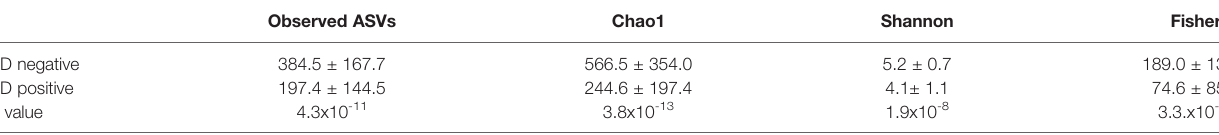
TABLE 2 | Alpha diversity estimates a of DD negative and DD positive skin